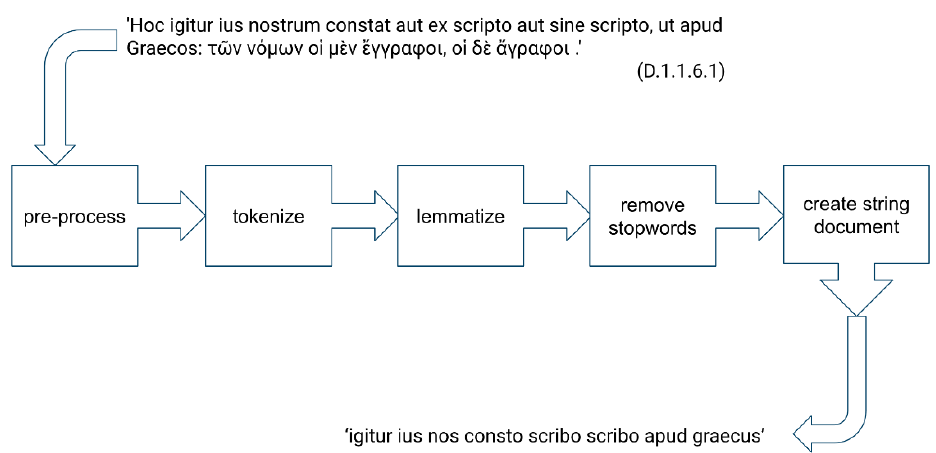
Figure 2. Pre-processing and the creation of lemmatized texts on the example of a passage from the Digest (Ulpian, Inst . 1, D.1.1.61).